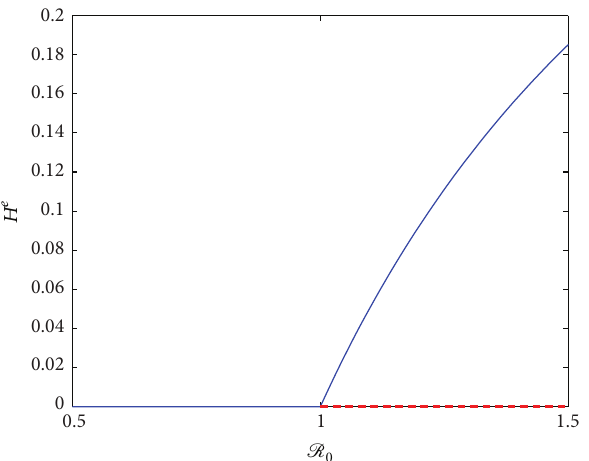
Figure 1: The bifurcation diagram for system (1). The solid line rep- resents stable equilibrium and the dashed line represents unstable equilibrium.